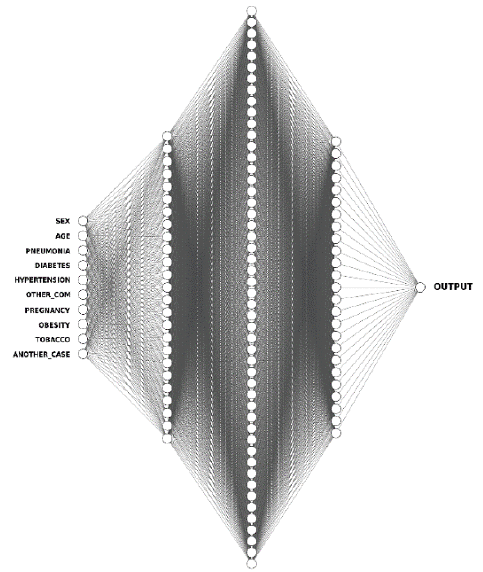
Figure 4. The architecture of ANN for this research.